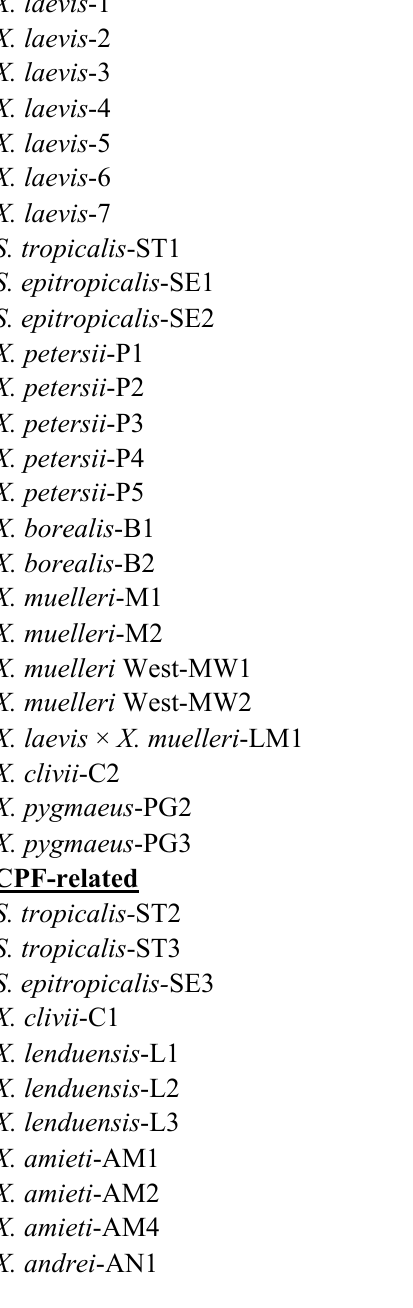
The CPF-related peptide, CPF-ST3 from S. tropicalis (formerly described as peptide XT-7 [37]), shows potent broad spectrum antimicrobial activity but is moderately hemolytic against